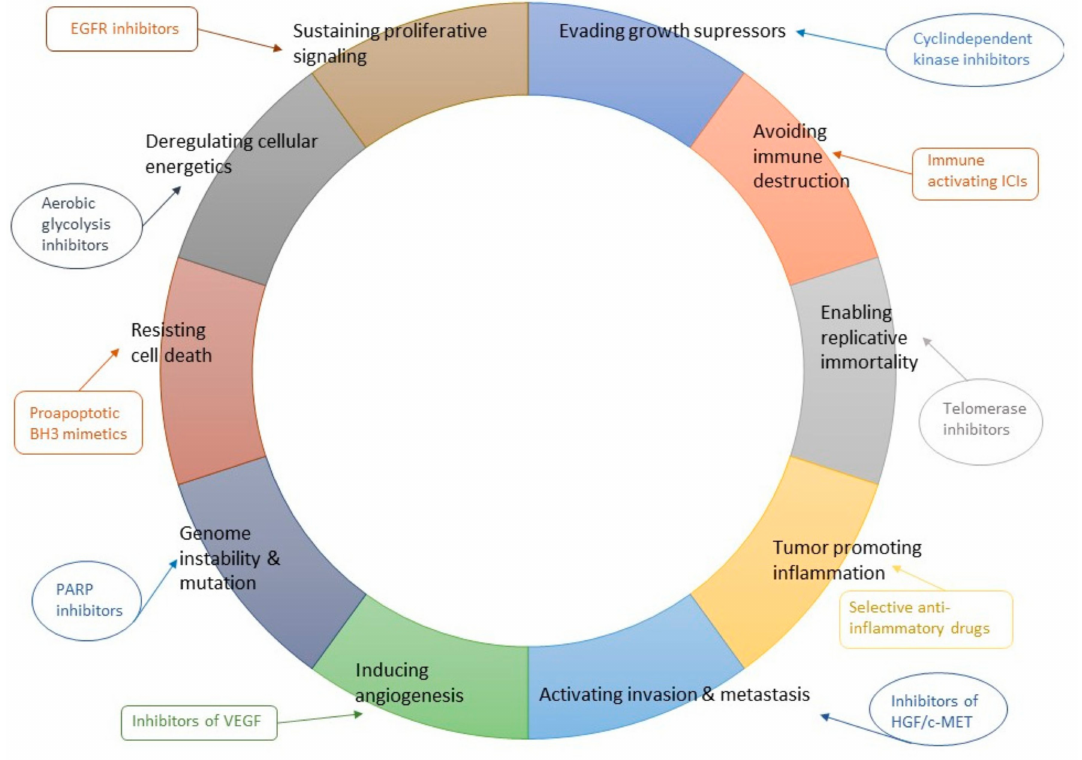
Figure 2. Therapeutic rationale of combinatory treatments based on hallmarks of